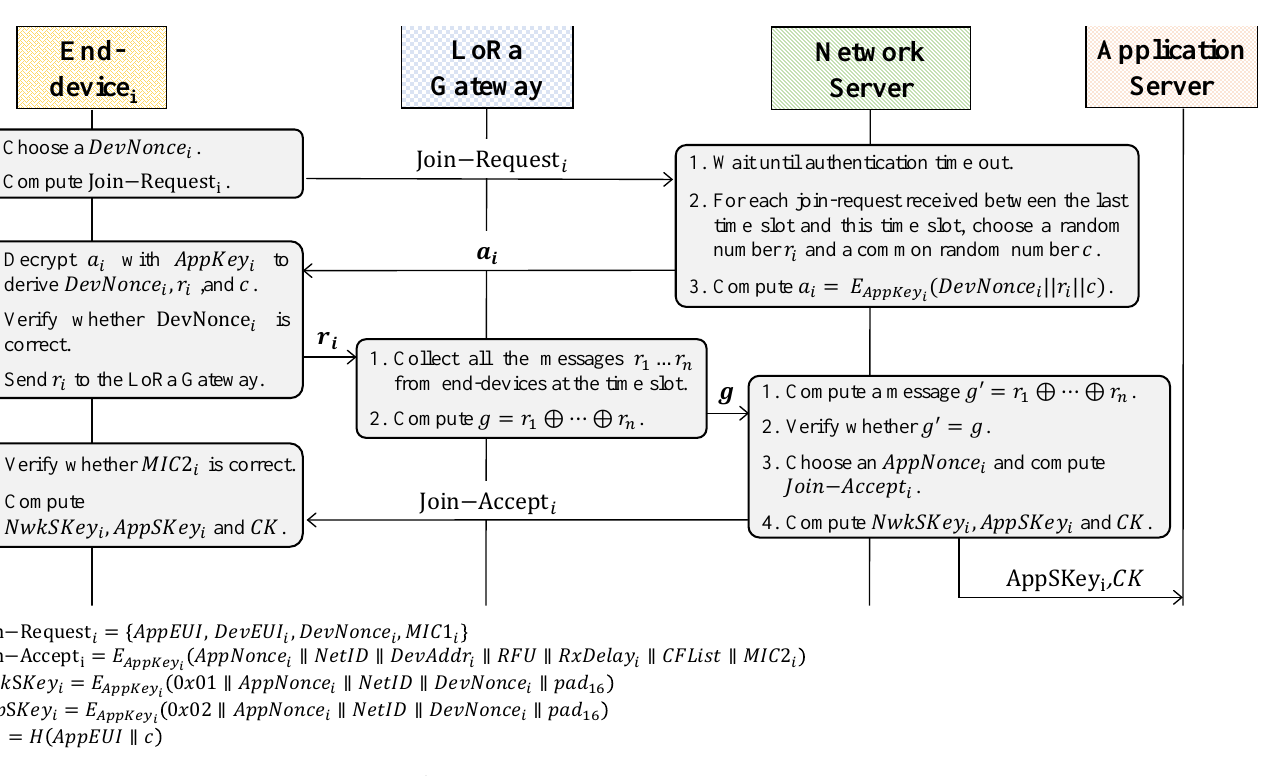
Figure 6. Authentication